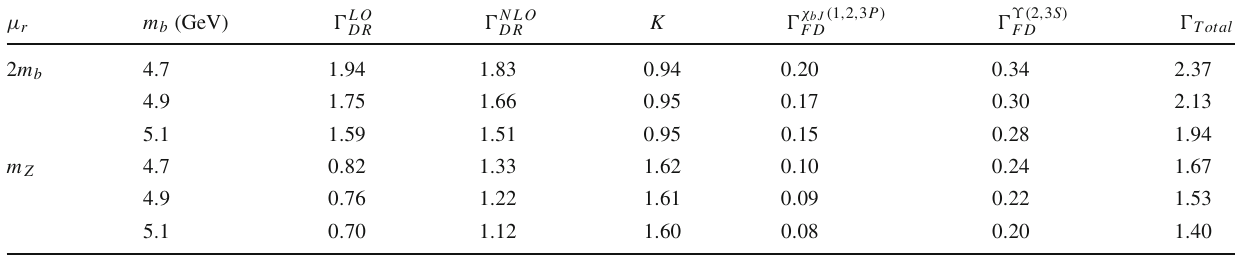
Table 1 The total decay widths of Z → ϒ( 1 S ) + g + g (in units of keV). K denotes (cid:6) NLO of the LO terms and that of the QCD corrections. The superscripts “DR” and “FD” denote the direct and feeddown contributions, respectively